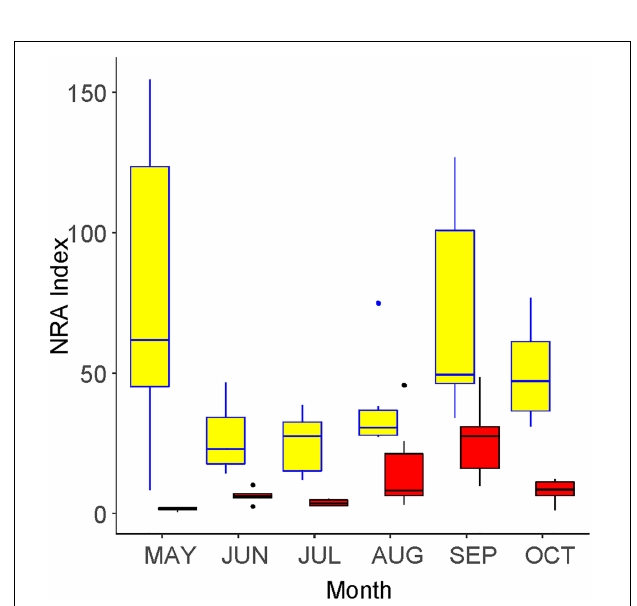
FIGURE 6 | Seasonal changes in the community-level nitrate reductase activity (NRA) inside (yellow) and outside (red) of an exclosure fence at a Zelkova serrata plantation in the University of Tokyo Chichibu Forest.